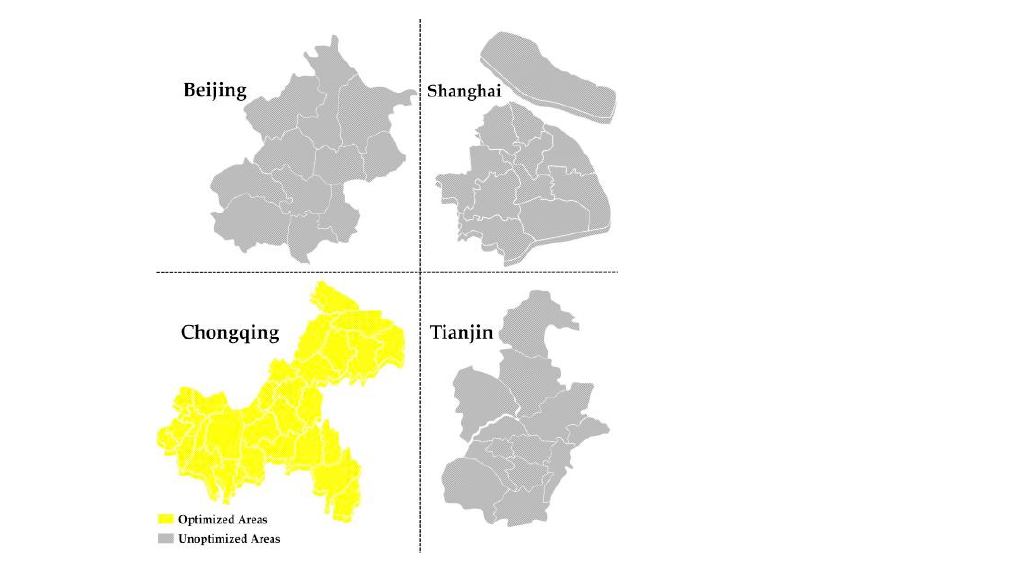
Figure 3. Spatio-temporal evolution pattern of LUE_Eco in Beijing, Shanghai, Chongqing, and Tianjin.